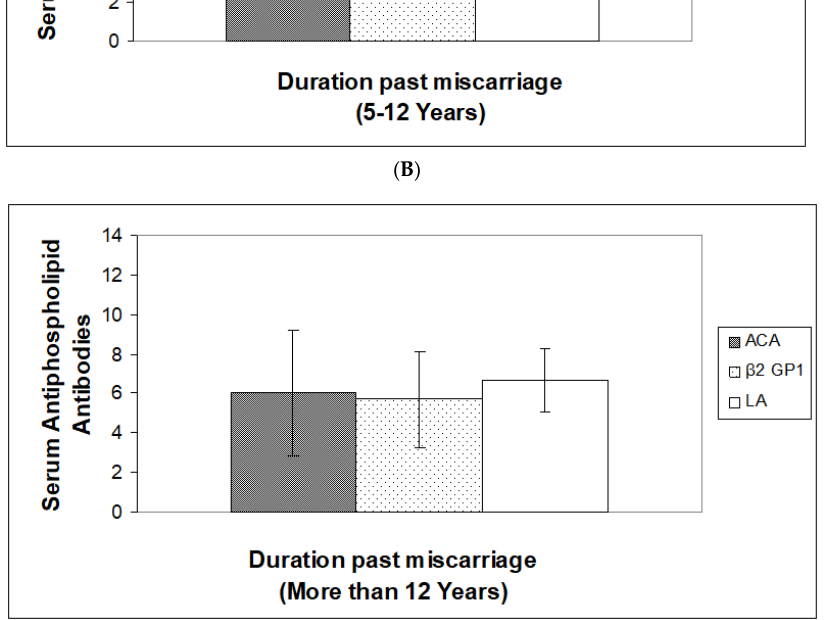
Figure 4. ( A ) Estimation of anticardiolipin (ACA), anti- β2 -glycoprotein- 1 (β2 GP1) and Lupus anticoagulants (LA) based on duration past miscarriages (≤ 4 years) in Saudi women. Values are Mean ± SD, ( n = 100), n = Total number of subject examinations. ( B ) Estimation of anticardiolipin (ACA), anti- β2 -glycoprotein- 1 (β2 GP1) and Lupus anticoagulants (LA) based on duration past miscarriages (5 – 12 years) in Saudi women. Values are Mean ± SD, ( n = 100), n = Total number of subject examinations. ( C ) Estimation of anticardiolipin (ACA), anti- β2 -glycoprotein- 1 (β2 GP1) and Lupus anticoagulants (LA) based on duration past miscarriages ( > 12 years) in Saudi women. Values are Mean ± SD, ( n = 100), n = Total number of subject examinations.